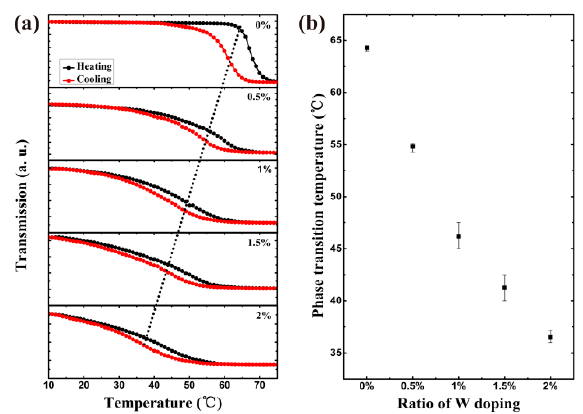
Figure 6. ( a ) Optical thermal hysteresis loop of VO 2 thin films with di ff erent W doping ratios. ( b ) Relationship between the PTT and doping ratio of W. The results come from three repeated experiments and the deviation of PTT is no more than 3%.